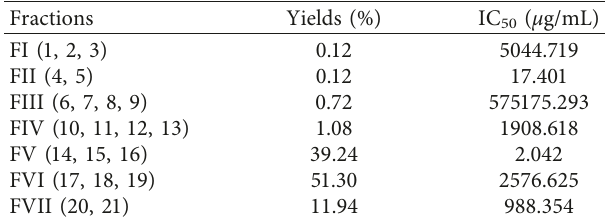
Figure 1: Test scheme of antimalarial activity prophylaxis in vivo of ethanolic leaf extract of S. androgynus against P. berghei . (a) Ad- ministration of extracts 4 consecutive days before parasitic infection (groups 1–4). (b) Administration of the extract 4 days before the parasitic infection and continued 4 days after the parasitic infection (group 5–8). Table 1: IC 50 value of the fraction from ethanolic leaf extract of S. androgynus